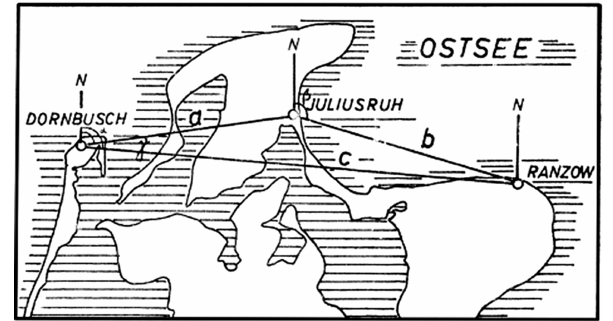
Figure 34. NLC observation network. a = 16.7km, b = 17.5km and c = 33.3km.